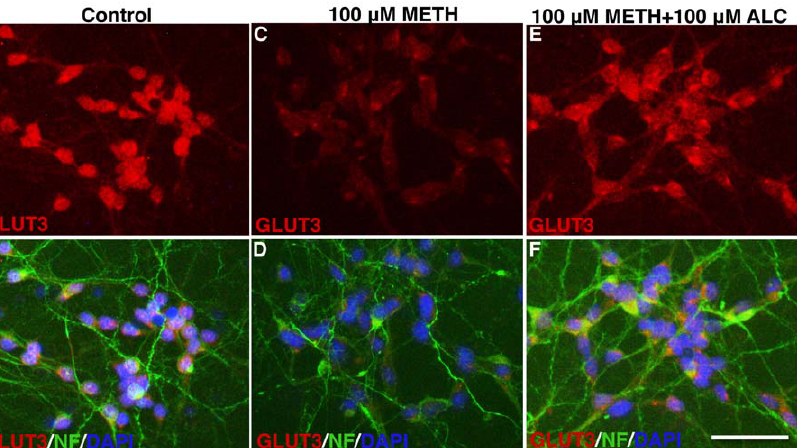
Figure 3. Effects of METH on GLUT3 expression in human neurons: Immunocytochemistry of GLUT3 (red) merged with NF (green) and DAPI (blue) in control ( A–B ), 20 m M METH ( C–D ), and 100 m M METH + 100 m M ALC ( E–F ). Rabbit anti-GLUT3 and mouse anti-NF were used as primary antibodies for overnight at 4 u C. Anti-rabbit-IgG Alexa Fluor 594 for GLUT3 and anti-mouse-IgG Alexa Fluor 488 for NF were used as secondary antibodies. Scale bar indicates 10 m m in all panels.